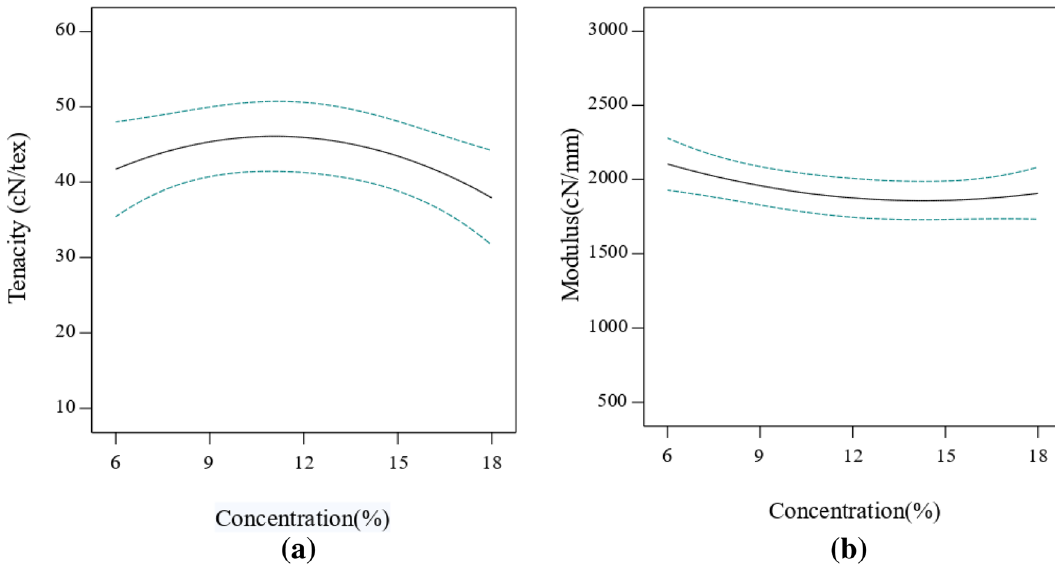
Fig. 9 Independent variables effect on the responses a Concentration versus Tenacity b Concentration versus